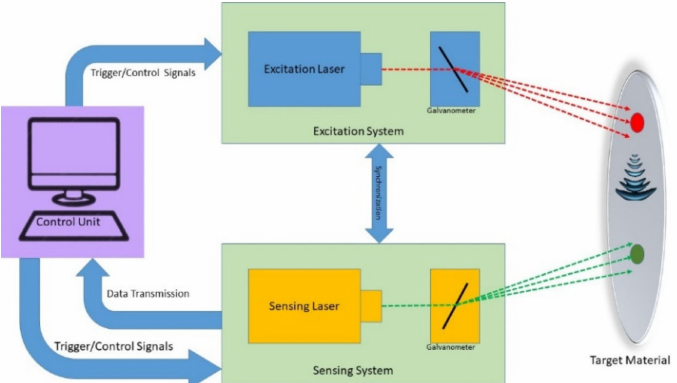
Figure 2. Block diagram of a photoacoustic imaging